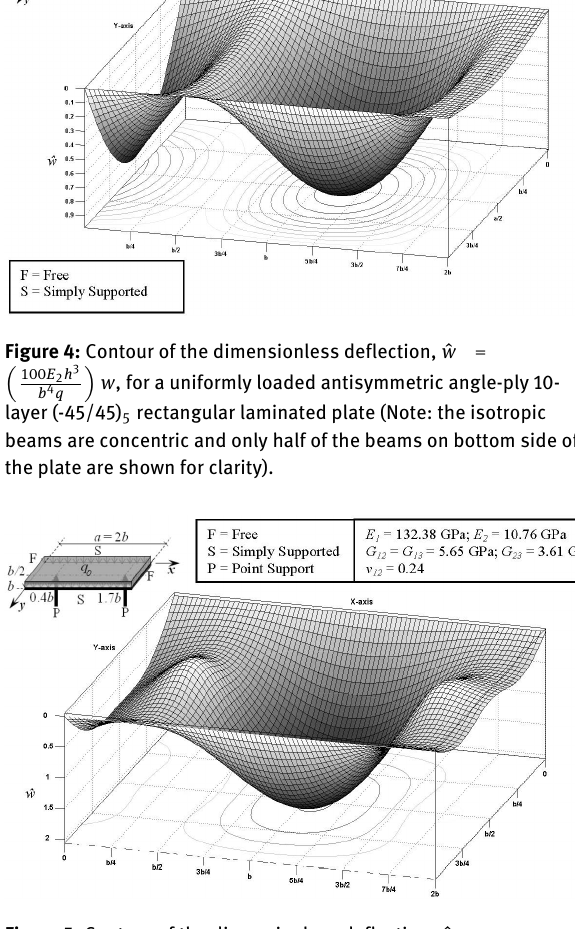
(︁ )︁ sionless deflections 100 ^ w ANSYS −^ w ASM is 0.21% at x = 0 ^ w ASM and y = a /2, 0.99% at the center of the patch load, 0.52% at the center span of the intermediate beam